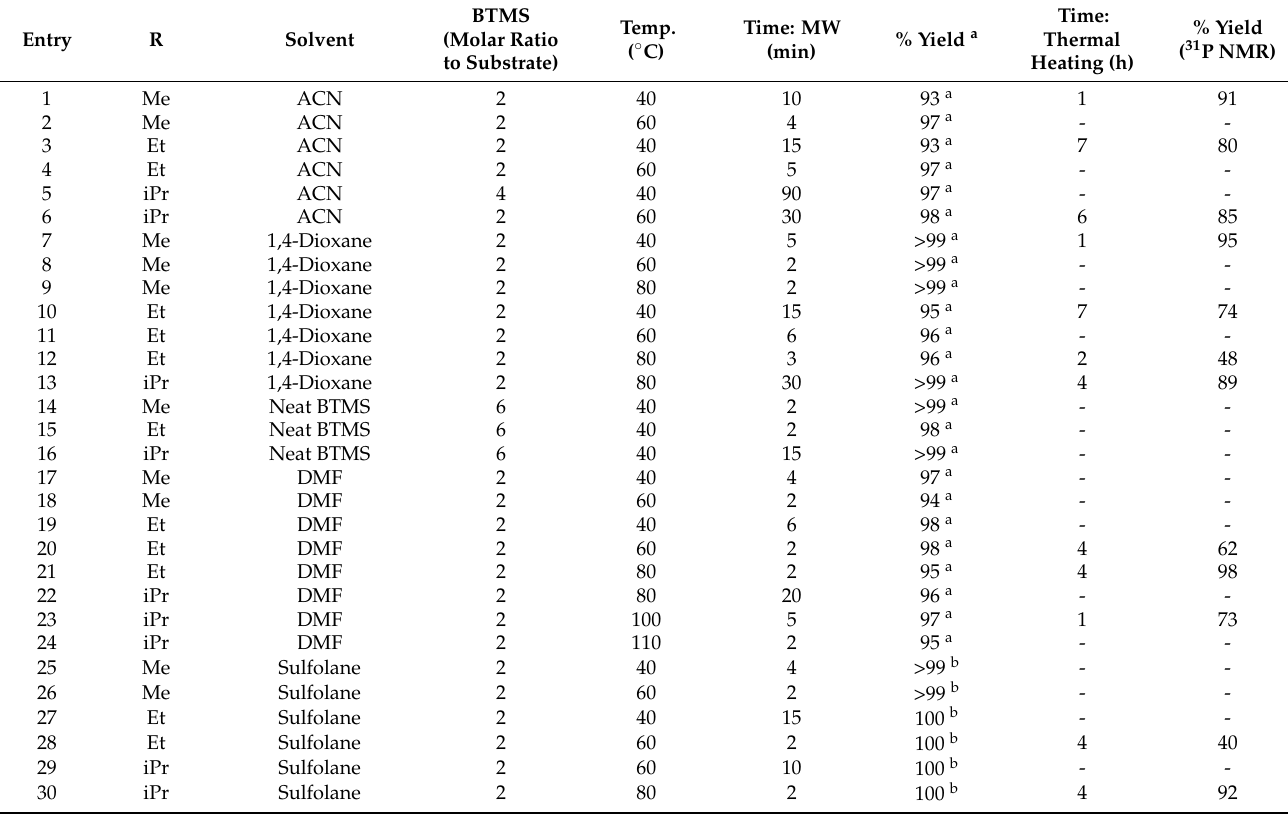
Table 1. Results for the dealkylation reactions represented in Scheme 1.